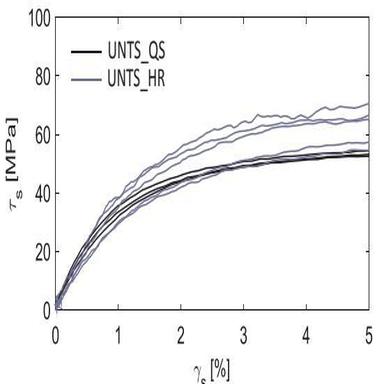
Shear stress-shear strain curves at QS and HR loading for γ ⩽ 5%.